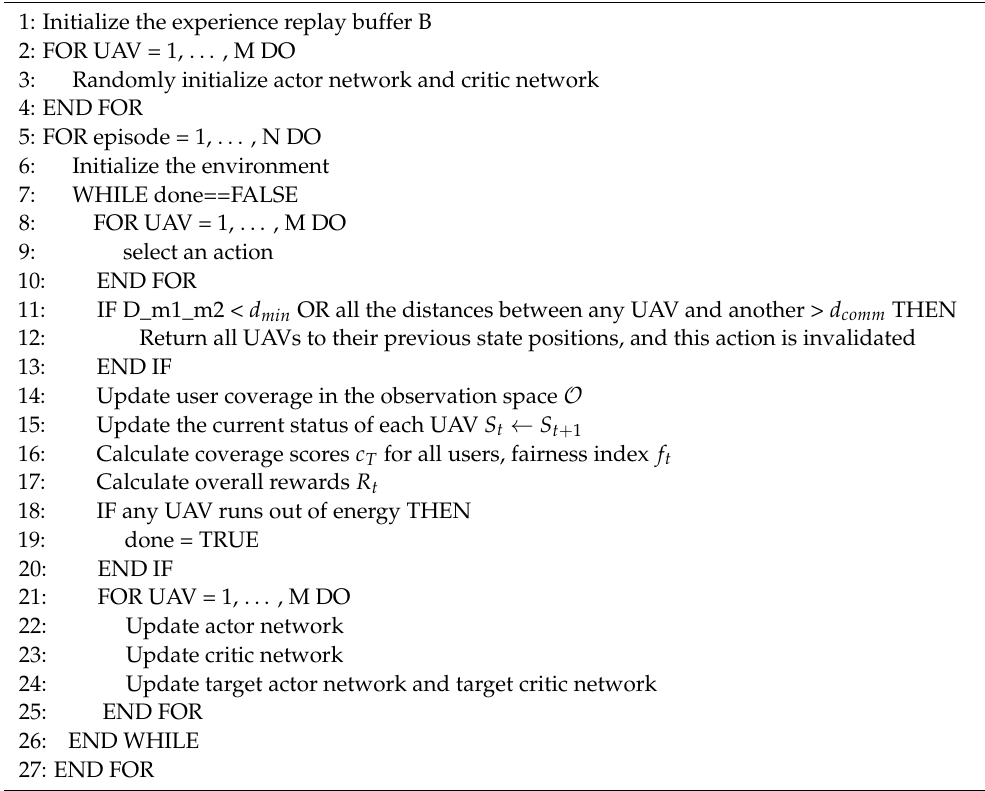
Algorithm 1 3D trajectory optimization algorithm based on